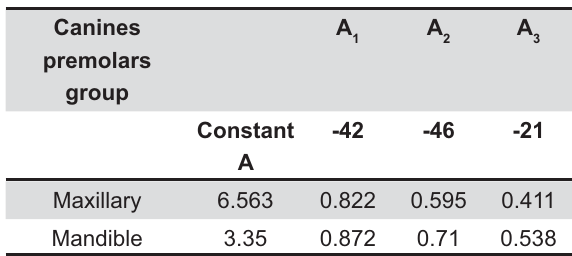
Table 1- Parameters of multiple linear regression equation used 3